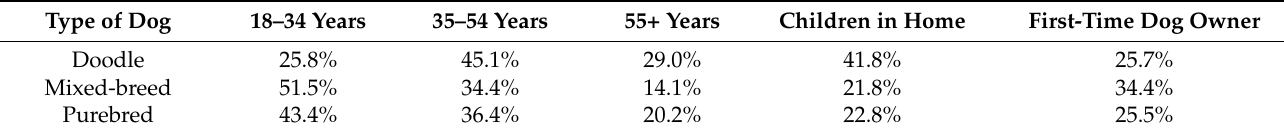
Table 1. Demographic characteristics of owners of each dog breed group.